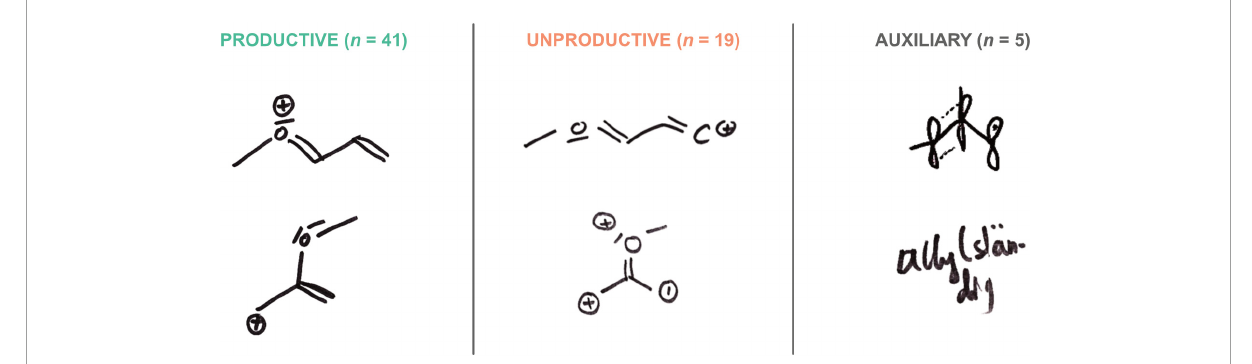
FIGURE3 Classification categories for the resulting drawings with student